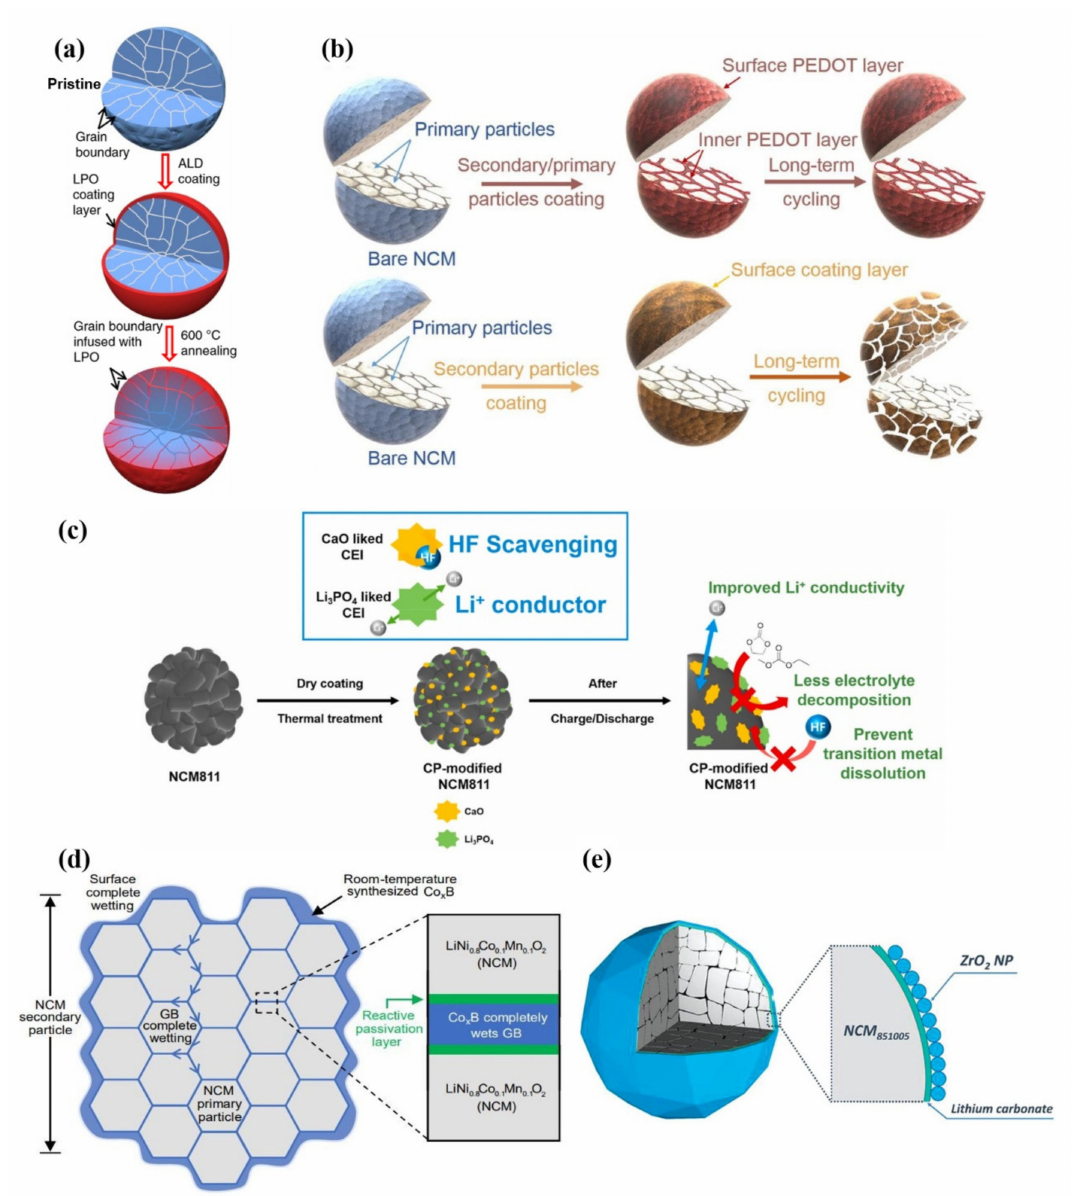
Figure 8. ( a ) Schematic diagram for the evolution of the LPO coating layer on the secondary particle. Reproduced with permission from ref. [98]. Copyright 2018 Springer Nature. ( b ) Grain boundary modification can ensure the structural stability of the cathode better than simple coating. Reproduced with permission from ref. [93]. Copyright 2019 Springer Nature. ( c ) Role of the surface-modified NCM811 cathode material dually functionalized by Ca 3 (PO 4 ) 2 . Reproduced with permission from ref. [84]. Copyright 2021 Elsevier. ( d ) Schematic “coating–plus–infusion” microstructure with Co x B for NCM primary particles. Reproduced with permission from ref. [102]. Copyright 2021 Springer Nature. ( e ) Schematic coating morphology. The protective coating has a unique bilayer structure, consisting of ZrO 2 NPs and (mostly) lithium carbonate. Reproduced with permission from ref. [81]. Copyright 2022 John Wiley and